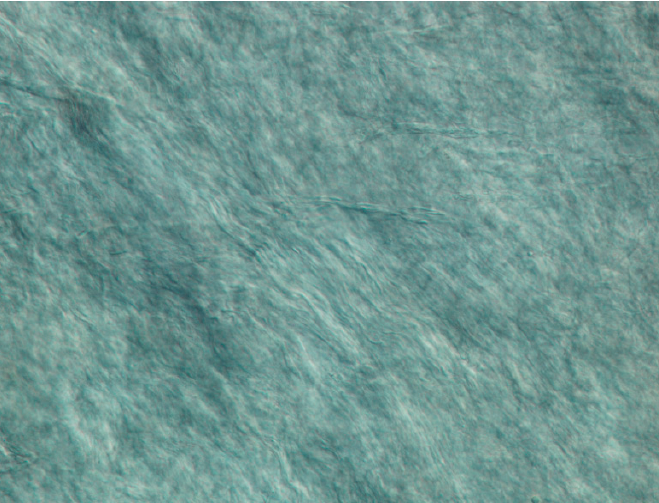
Figure 2. Differential interference contrast (DIC) microscopy image of the surface of the bovine amnion. Image width is 300 µm (magnification ×310).